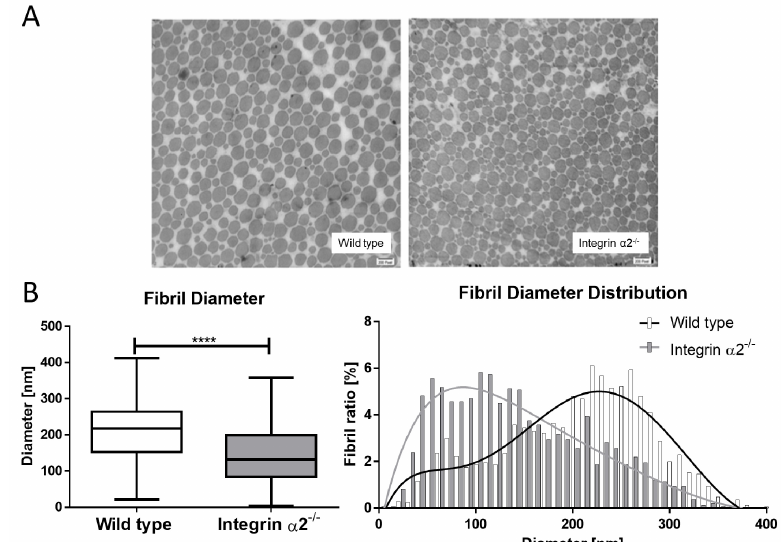
Figure 2. Collagen fibrils are thinner in integrin α 2 β 1-deficient tendons. Overview of a transmission electron micrograph of integrin α 2 β 1-deficient and wild-type tendons ( A ). Distribution of fibril ration to diameter, and > 1600 fibrils / genotype from four di ff erent tendons were measured ( B ). Mann-Whitney U test was used for statistical testing (**** p < 0.0001). Int. J. Mol. Sci. 2020 , 21 , x FOR PEER REVIEW